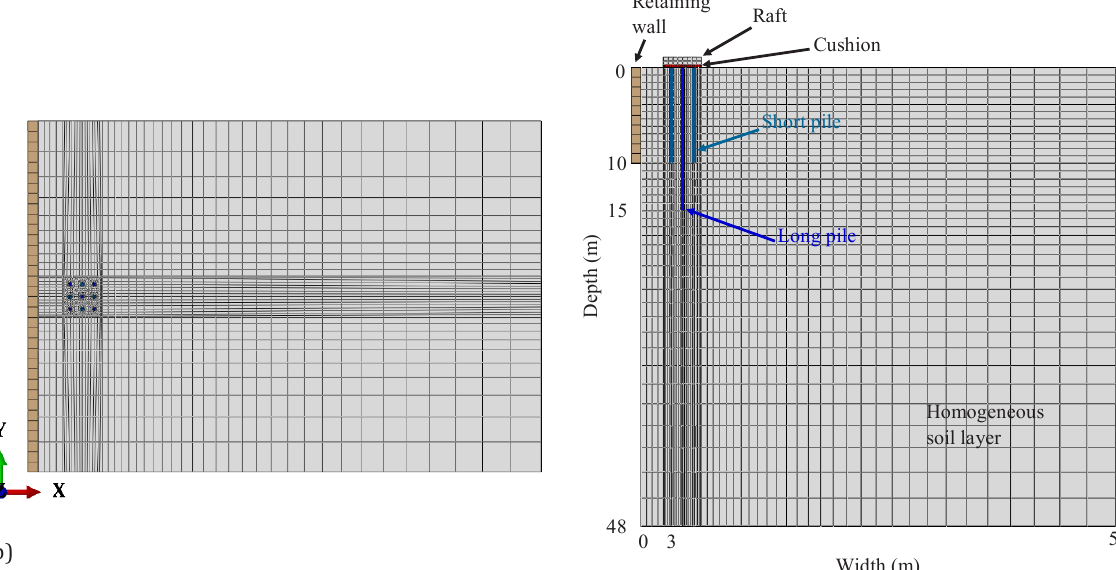
b) Figure 1: Typical (a) plan and (b) sectional view of finite element mesh used for nine long–short pile composite foundation at 3-m distance away from